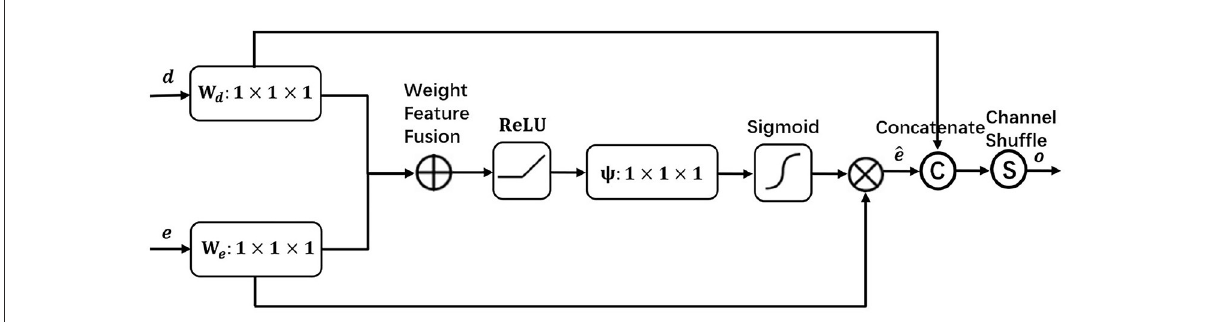
FIGURE3 The visual attention module focuses on the salient features of the target in the local area, suppresses the surrounding background interference, and detects the object effectively.